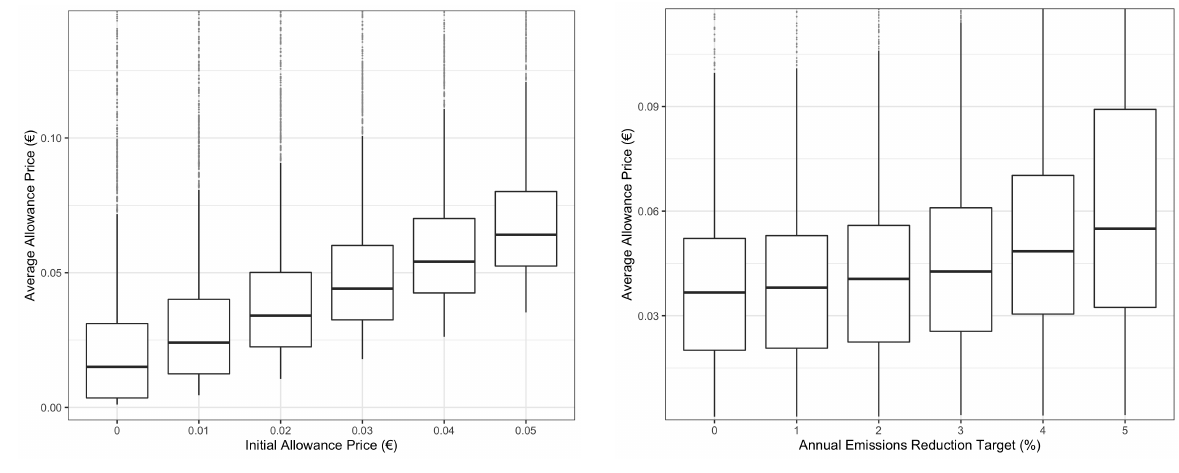
Figure 4. ( a ) shows how the reduction target set at simulation start influences average price and ( b ) the cumulative emission reductions. The results make clear how choosing the target is an influential policy adjusting screw. In later time steps, in particular, the decreasing allocation of allowances results in increasing price and higher emission reductions.